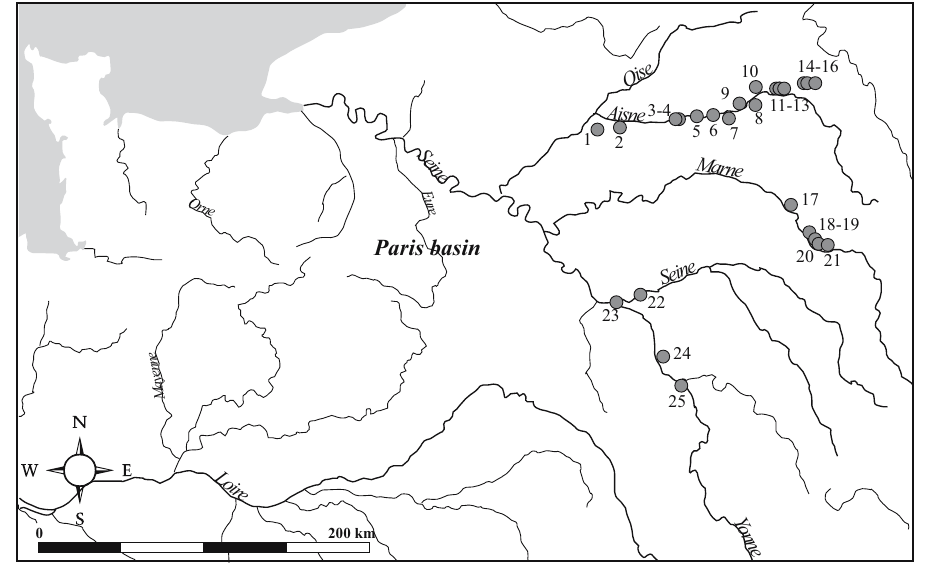
Figure 1: Distribution of LBK settlements in the Paris Basin with faunal assemblages that have been studied or are undergoing study ( map: L. Bedault ) : ( 1 ) Pont - Saint - Maxence “ le Jonquoire ” ; ( 2 ) Osly - Courtil “ la Terre Saint - Mard ” ; ( 3 and 4 ) Bucy - le - Long “ la Fosselle ” - Bucy - le - Long “ la Héronnière/la Fosse Tounise ” ; ( 5 ) Missy - sur - Aisne “ le Culot ” ; ( 6 ) Chassemy “ le Grand Horle ”